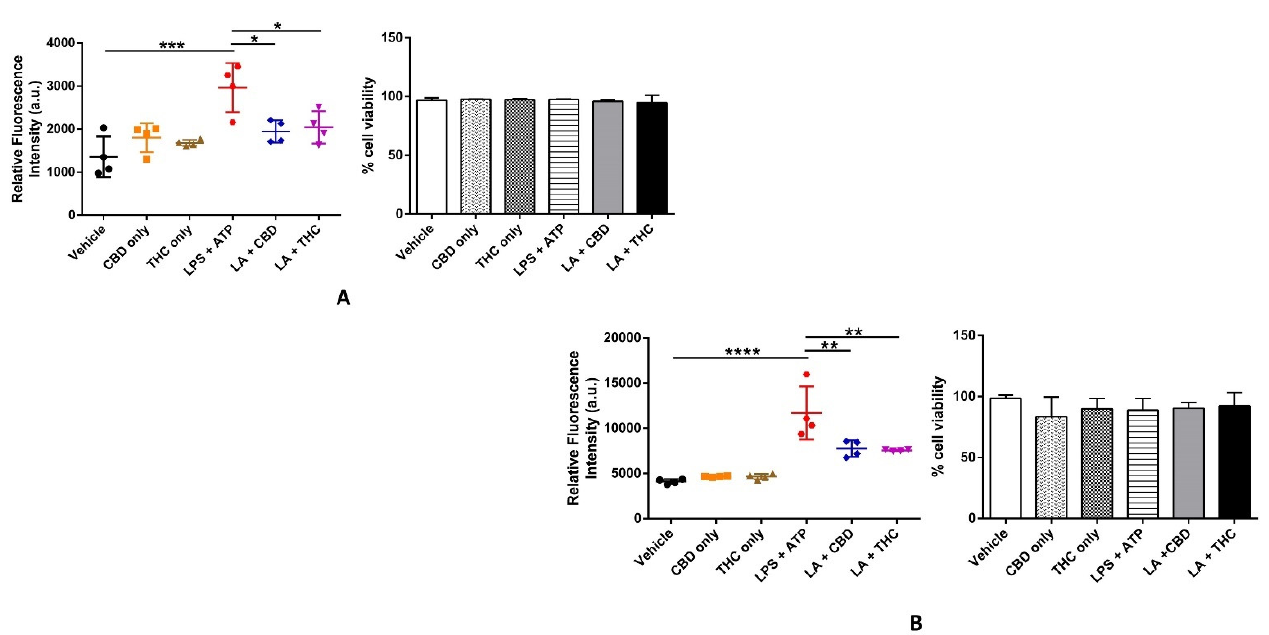
Figure 5. Effect of cannabinoids on ROS generation and cell viability in THP-1 macrophages and primary human bronchial epithelial cells. ( A ): CBD and THC decreased the cellular ROS levels after LPS + ATP stimulation without affecting cell viability in THP-1 macrophages: The ROS levels and % cell viability were measured using cellular ROS assay kit (Abcam) and trypan blue assay, respectively and quantified using one-way ANOVA with Tukey’s multiple-comparison test. Four independent experiments ( n = 4) for ROS assay and three independent experiments ( n = 3) for trypan blue assay from THP-1 cells obtained after pre-treatment with CBD or THC for 30 min and LPS stimulation for 3 h followed by ATP 1 h were performed, and data are expressed as means ± SD; * p < 0.05, *** p < 0.001. Each independent experiment was run in duplicates for both assays. (Abbreviation: LA: LPS + ATP). ( B ): CBD and THC decreased the cellular ROS levels after LPS + ATP stimulation without affecting cell viability in primary HBECs: The ROS levels and % cell viability were measured using cellular ROS assay kit (Abcam) and trypan blue assay, respectively and quantified using one-way ANOVA with Tukey’s multiple-comparison test. Four independent experiments ( n = 4) for ROS assay and three independent experiments ( n = 3) for trypan blue assay from primary HBECs obtained after pre-treatment with CBD or THC for 30 min and LPS stimulation for 8 h followed by ATP 1 h were performed, and data are expressed as means ± SD; ** p < 0.01, **** p < 0.0001. Each independent experiment was run in duplicates for both assays. (Abbreviation: LA: LPS + ATP; HBECs: Human bronchial epithelial cells).